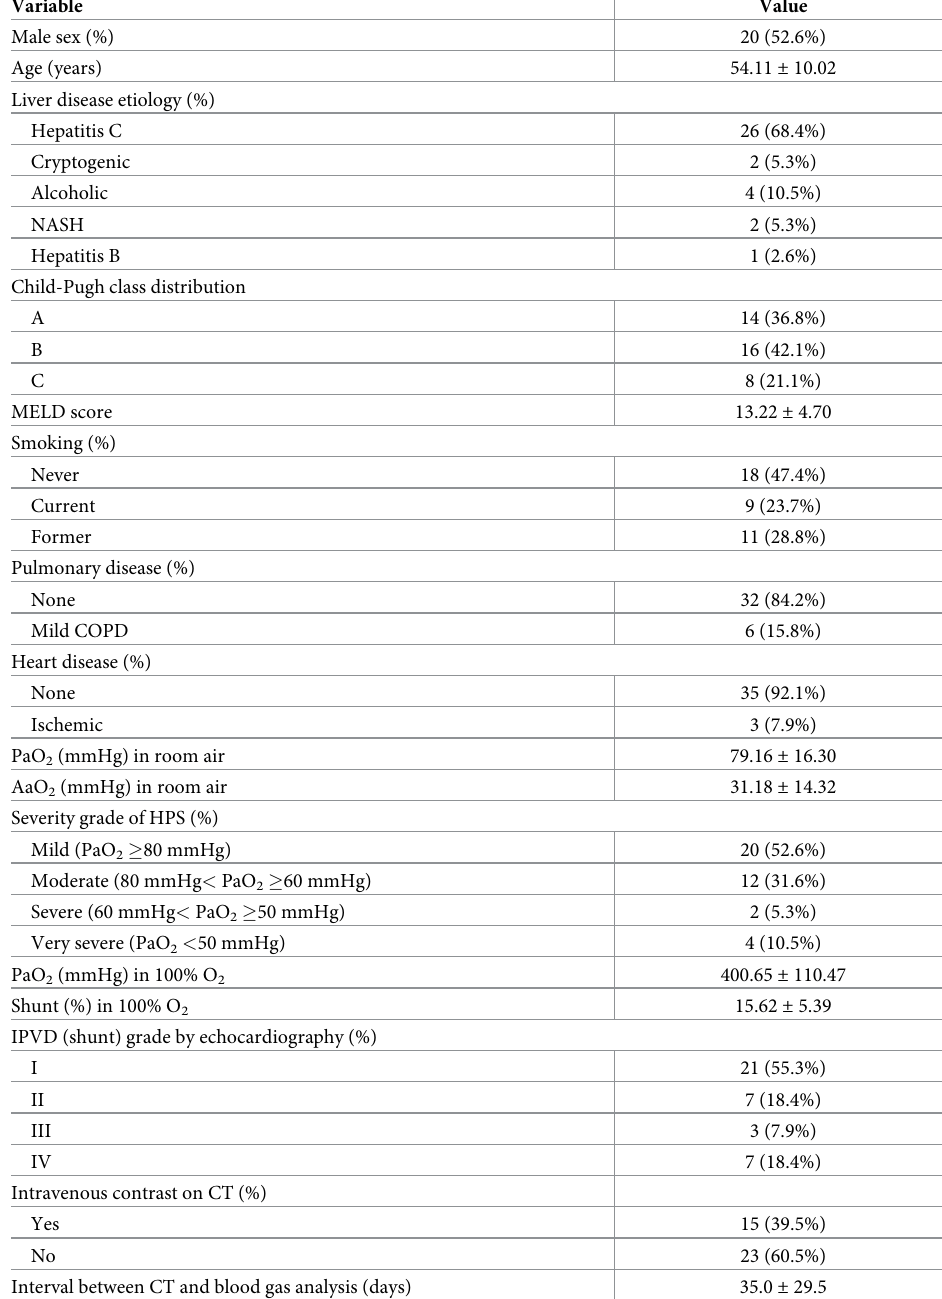
Table 1. Patient demographics and clinical